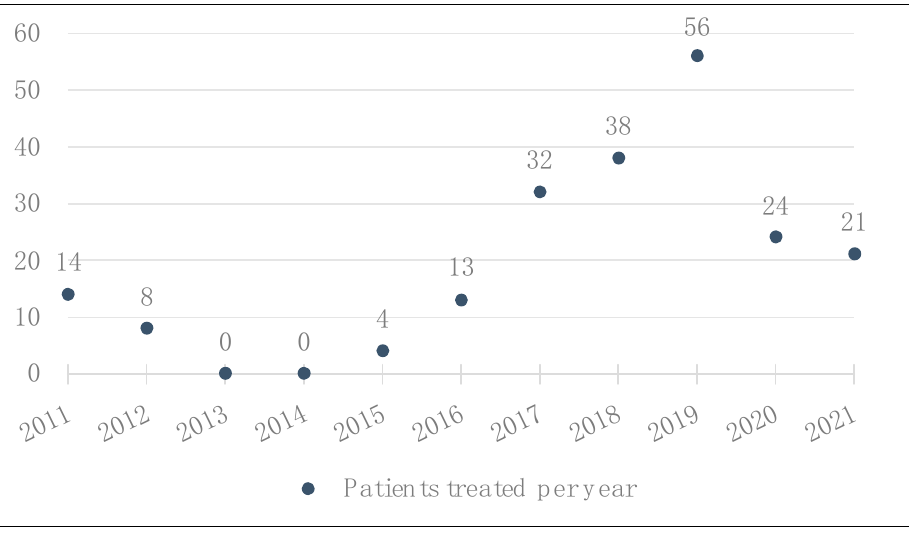
Figure 1. Total number of patients with advanced or metastatic melanoma who received treatment with ICB at BCH, by year.